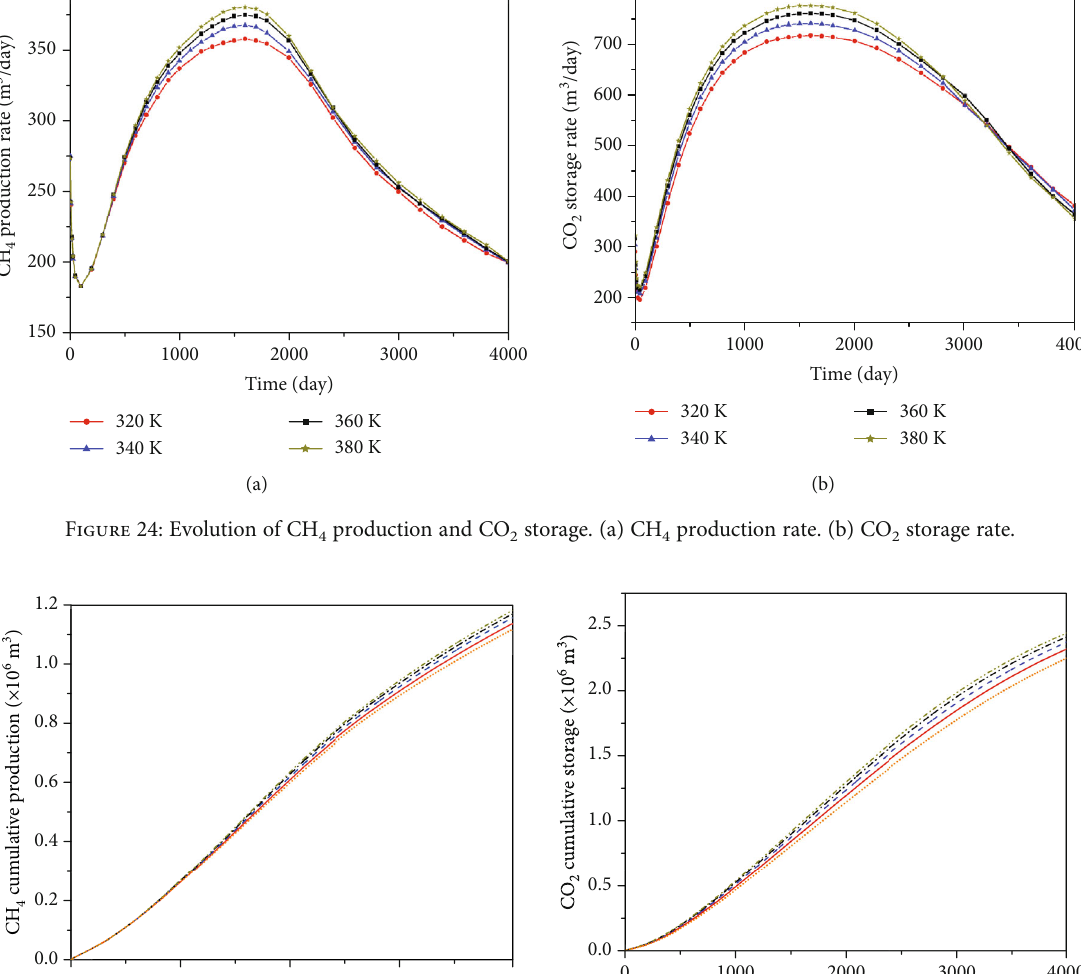
cumulative storage under di ff erent injection temperatures. (a) CH 2